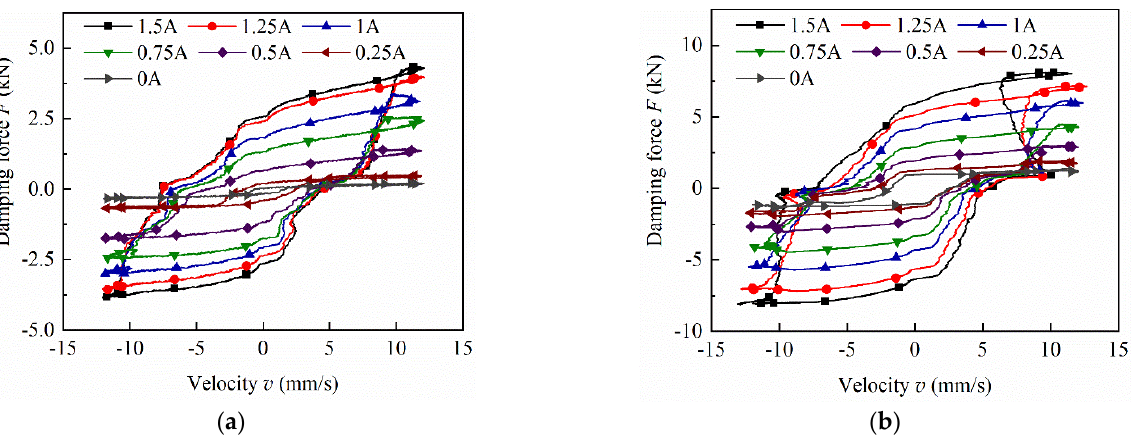
Figure 20. Damping force versus velocity under different currents: ( a ) initial; ( b ) optimal.